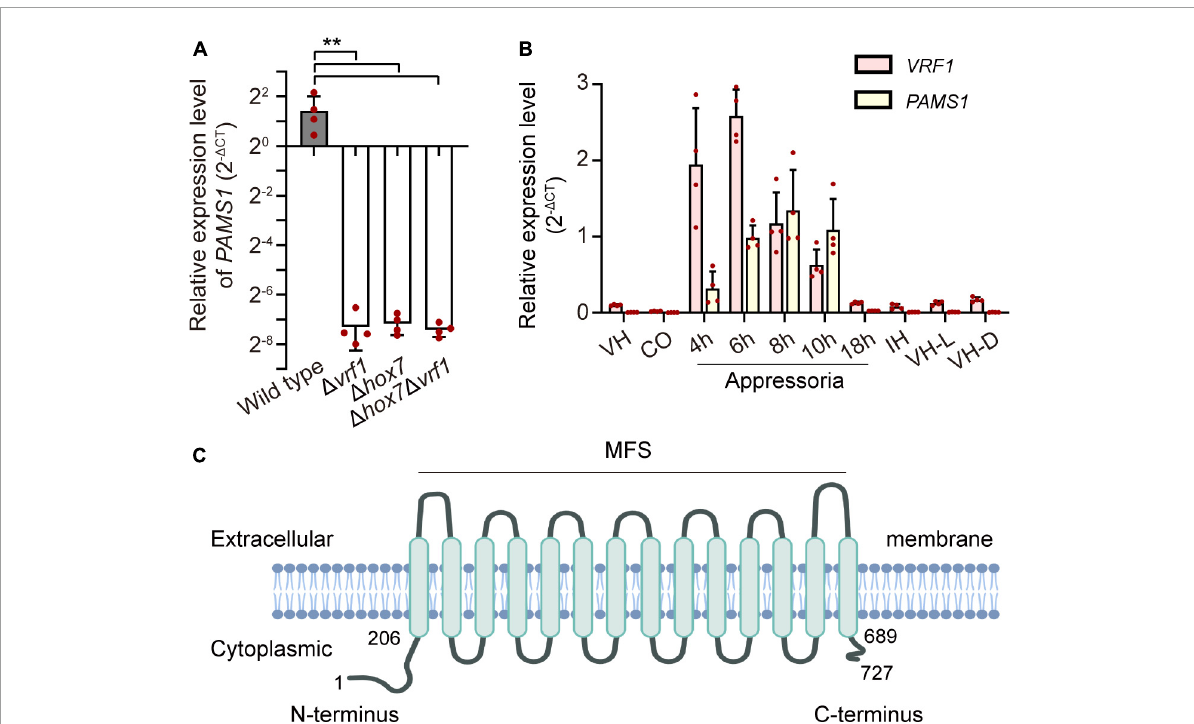
FIGURE1 Identification of an appressorium membrane protein Pams1 in M. oryzae . (A) Relative expression levels of PAMS1 in 5-hpi appressoria of the wild type and (cid:49) vrf1 , (cid:49) hox7 , and (cid:49) hox71 (cid:49) vrf1 ( n = 4). ** P < 0.01. (B) Relative transcript levels of PAMS1 and VRF1 in the wild type ( n = 4). VH, vegetative hyphae in CM. CO, conidia. 4–18 h, appressoria sampled at 4–18 hpi. IH, invasive hyphae in barley at 2 dpi. VH-L or VH-D, aerial hyphae cultured under light or darkness, respectively. 40S and α - ACTIN are used as reference genes in panels (A,B) . (C) Transmembrane helices in Pams1 were predicted by the TMHMM software and NCBI conserved domain